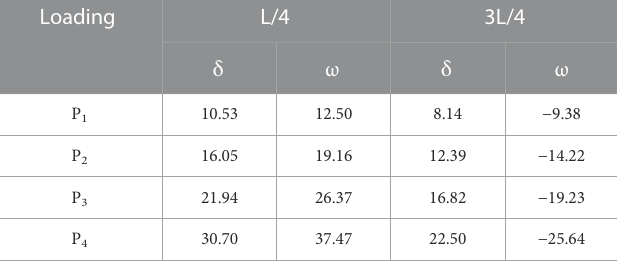
TABLE 10 A-2 arch P 1 ~P 4 measured displacement (unit: mm).